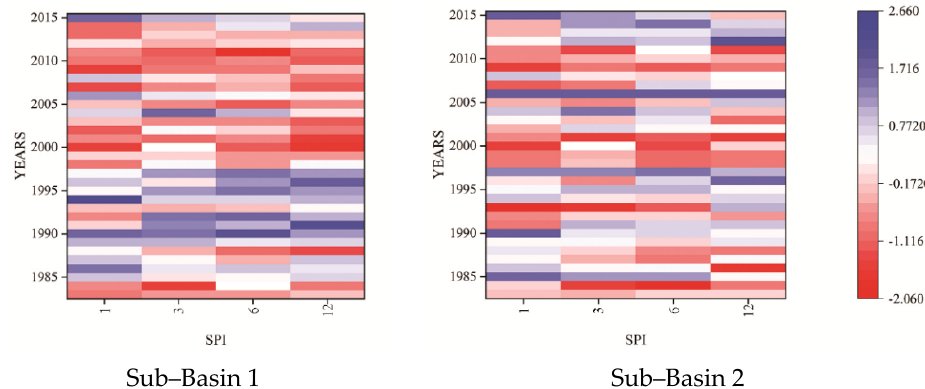
Figure 2. Temporal variations of meteorological drought periods during 1983 – 2015 in sub – basins 1 and 2.